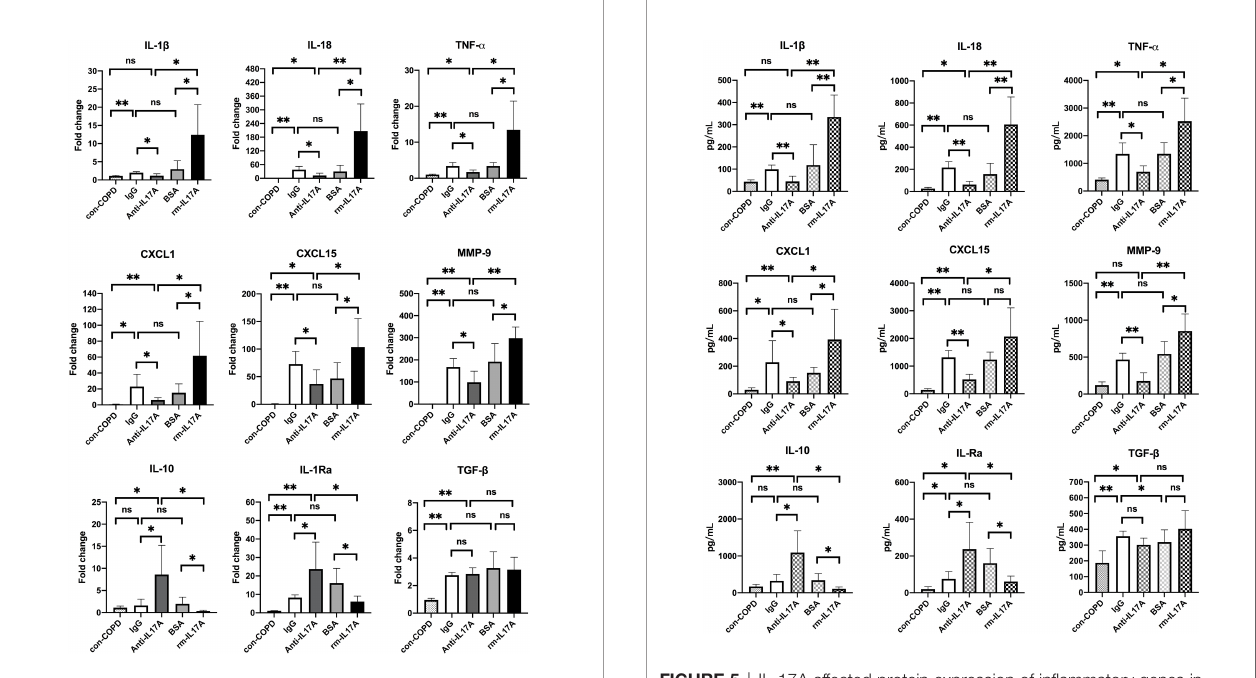
FIGURE 4 | IL-17A affected transcription of in fl ammatory genes in responses to P. aeruginosa infection in COPD mouse models. Mice were intraperitoneally injected with IL-17A – neutralizing antibody (2 mg/kg) or recombinant-IL-17A (1.6 mg/kg) 4 h before the inoculation with 1.0 × 10 5 CFU P. aeruginosa . Mouse IgG and BSA served as controls, respectively. COPD mouse models inoculated with sterile agar beads served as blank control (con-COPD). Lungs were excised at 24 h post inoculation and analyzed by real-time PCR. Data are presented as mean ± SD ( n = 5